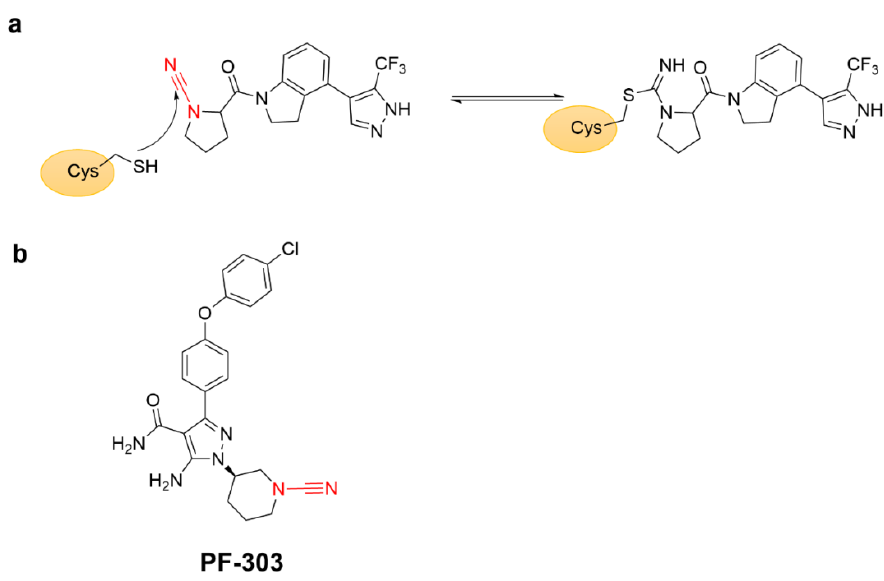
Figure 16. ( a ) The mechanism of covalent adduct formation between cyanopyrrolidine covalent in ‐ hibitor (red) and Cys481. ( b ) Chemical structure of the BTK inhibitor PF ‐